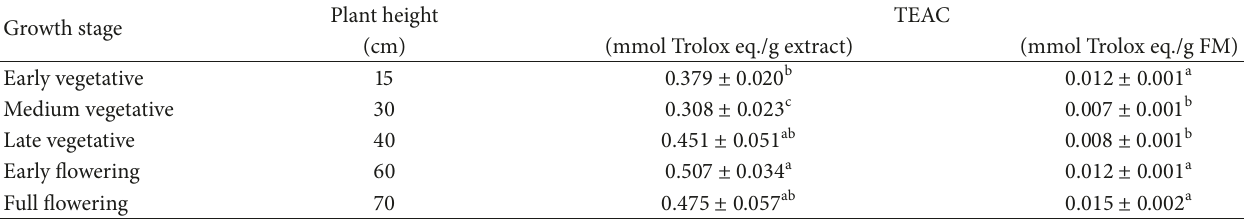
Table 4: Trolox equivalent antioxidant capacity (TEAC) of the perilla extract and fresh matter (FM) at different growth stages. Growth stage